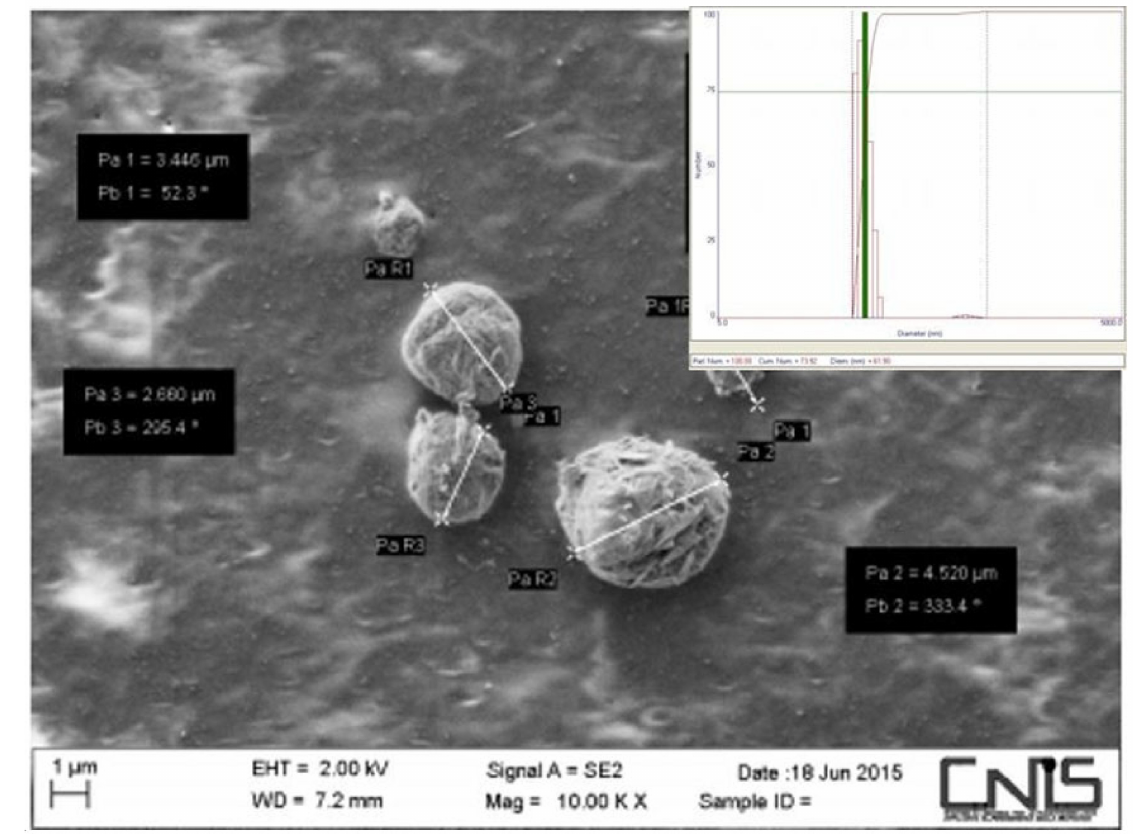
Figure 6. Micro capsules of chitin–lignin and their size at SEM.